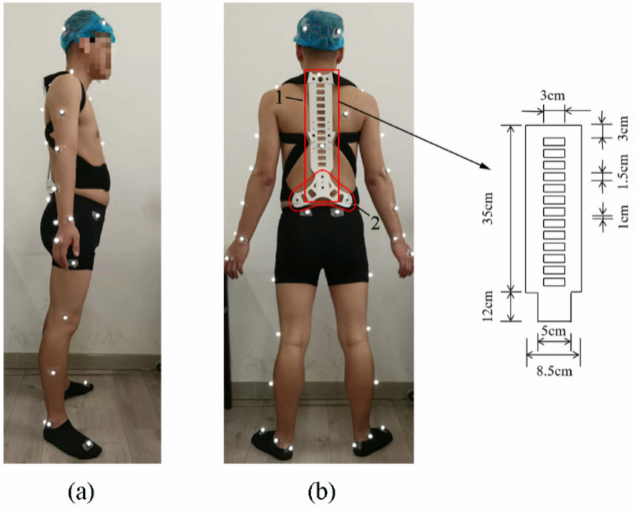
Figure 1. Reflective markers were attached to the anatomical skeleton landmarks of a subject. ( a ) Side view of the spinal orthosis; ( b ) back view of the spinal orthosis (1 titanium alloy plate and 2 plastic